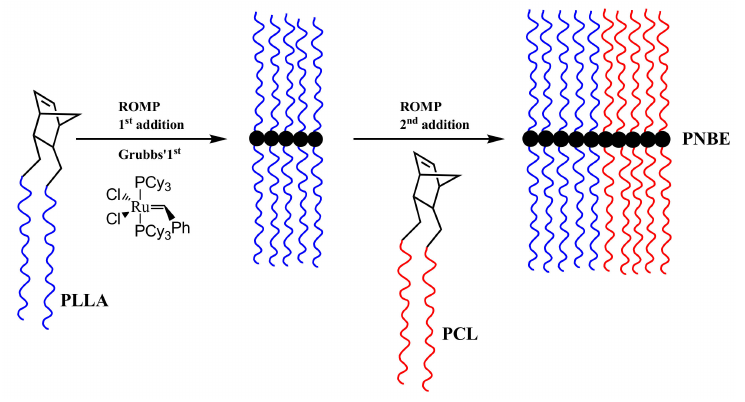
Figure 11. Synthesis of